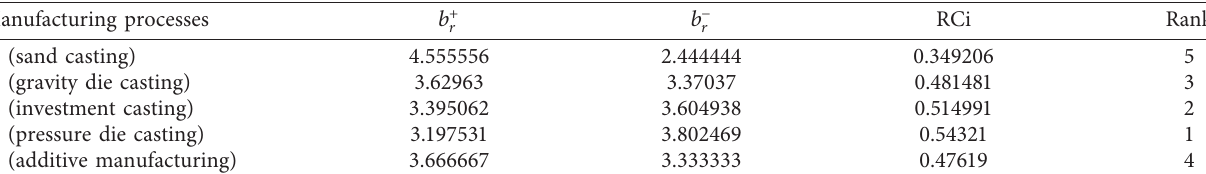
Table 10: Outranking of alternative manufacturing processes based on TOPSIS.